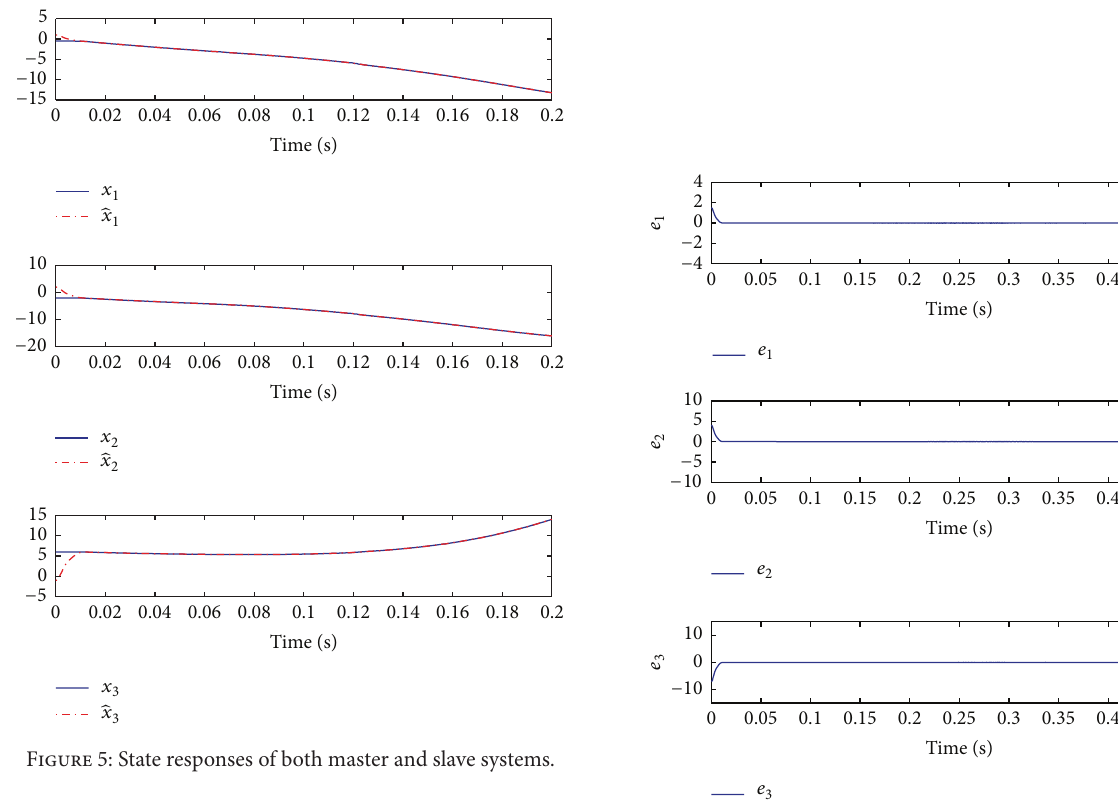
Figure 6: The chaotic behaviors of the master and the slave systems.